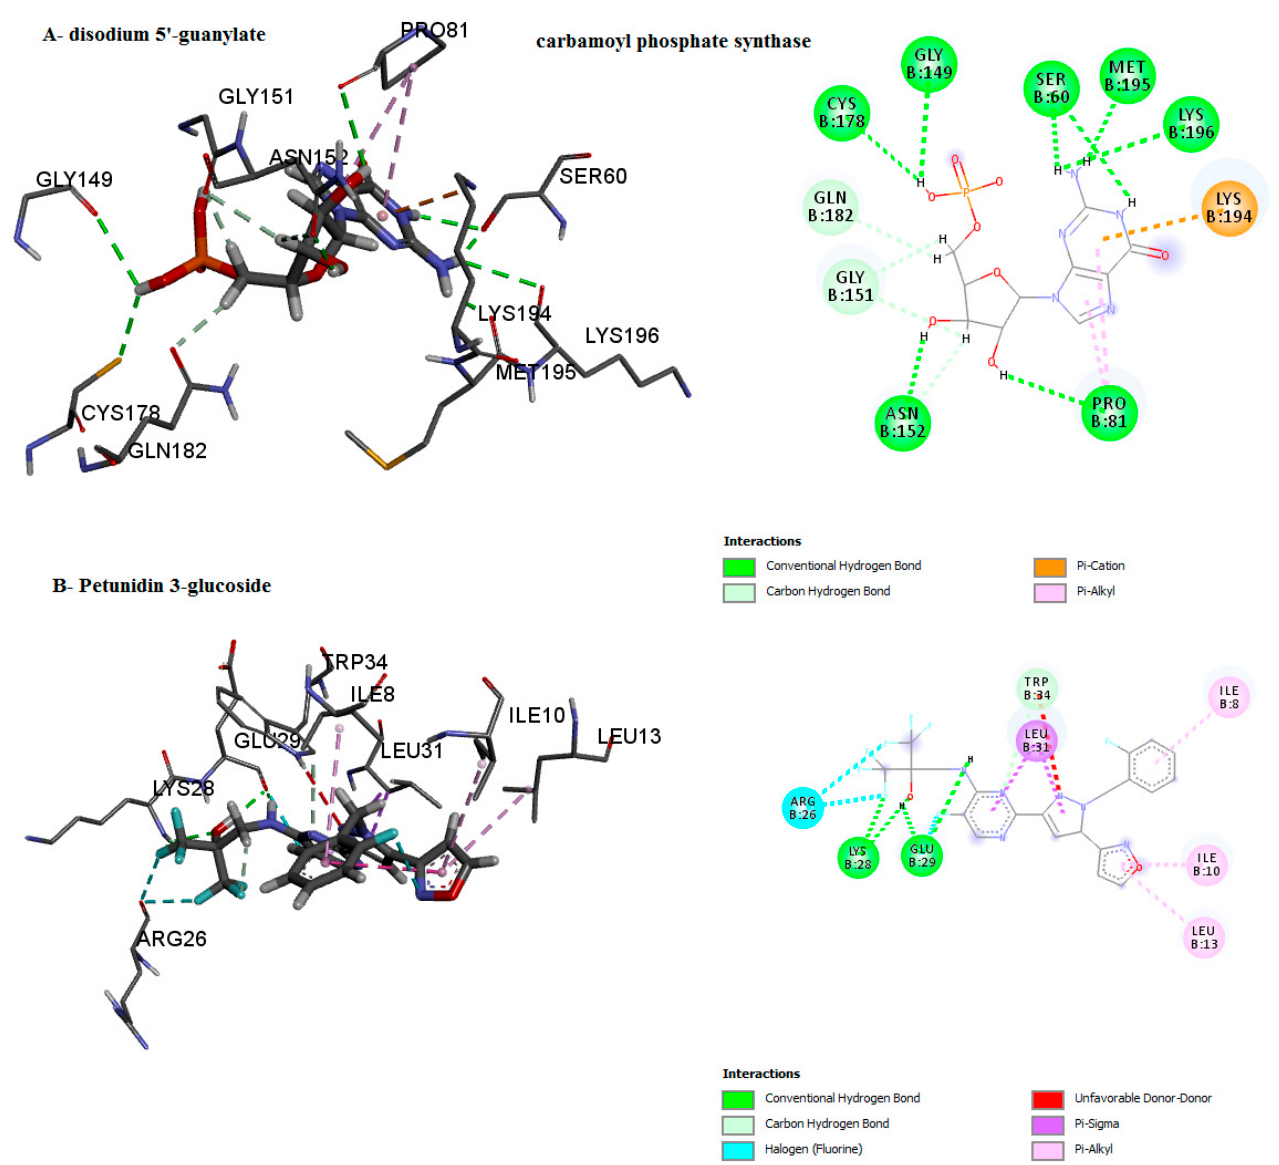
Figure 9. Predicted binding mode for carbamoyl phosphate synthase with disodium 5 ′ -guanylate and petunidin 3-glucoside.